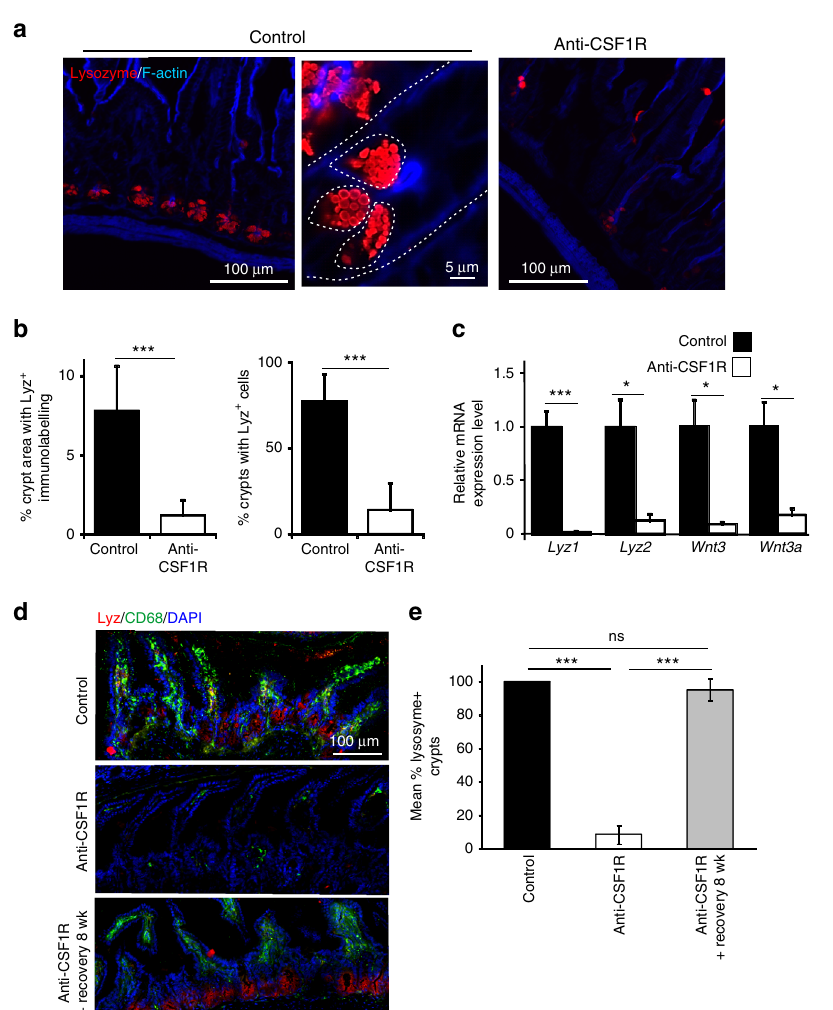
Fig. 2 Prolonged anti-CSF1R blockade leads to a loss of lysozyme-expressing Paneth cells in the crypts. Mice were treated with anti-CSF1R mAb or control- IgG (control) for 6 weeks before subsequent analysis. a IHC analysis shows loss lysozyme-expressing Paneth cells (red) in intestinal crypts after anti- CSF1R-treatment. Broken line indicates crypt and Paneth cell boundaries. Images are representative of 4 mice/group from 3 independent experiments. b Morphometric analysis of the density of lysozyme-expressing Paneth cells in the crypts after anti-CSF1R mAb treatment (open bars) when compared to controls (closed bars). Data represent mean ± SD from 6 to 20 sections from four mice/group, and are representative of data derived from three independent experiments. *** P < 0.001, Mann – Whitney U -test. c RT – qPCR analysis shows negligible expression of Lyz1, Lyz2 , Wnt3 , and Wnt3a in mRNA from isolated intestinal crypts following treatment with anti-CSF1R mAb. Data are normalized to the expression of Gapdh . Bars represent mean ± SEM. Data are derived from four mice/group. * P < 0.05; *** P < 0.001, two-tailed unpaired Student ’ s t -test. d Mice were treated with anti-CSF1R mAb or control-IgG (control) for 6 weeks. A parallel group of mice were allowed to recover for 8 week following anti-CSF1R mAb. IHC analysis shows loss lysozyme-expressing Paneth cells (red) in intestinal crypts and CD68 + macrophages (green) in the gut wall after anti-CSF1R-treatment. The presence of lysozyme-expressing Paneth cells mice from each treatment group. Data represent mean ± SD from sections from 3 to 4 mice/group, and 30 to